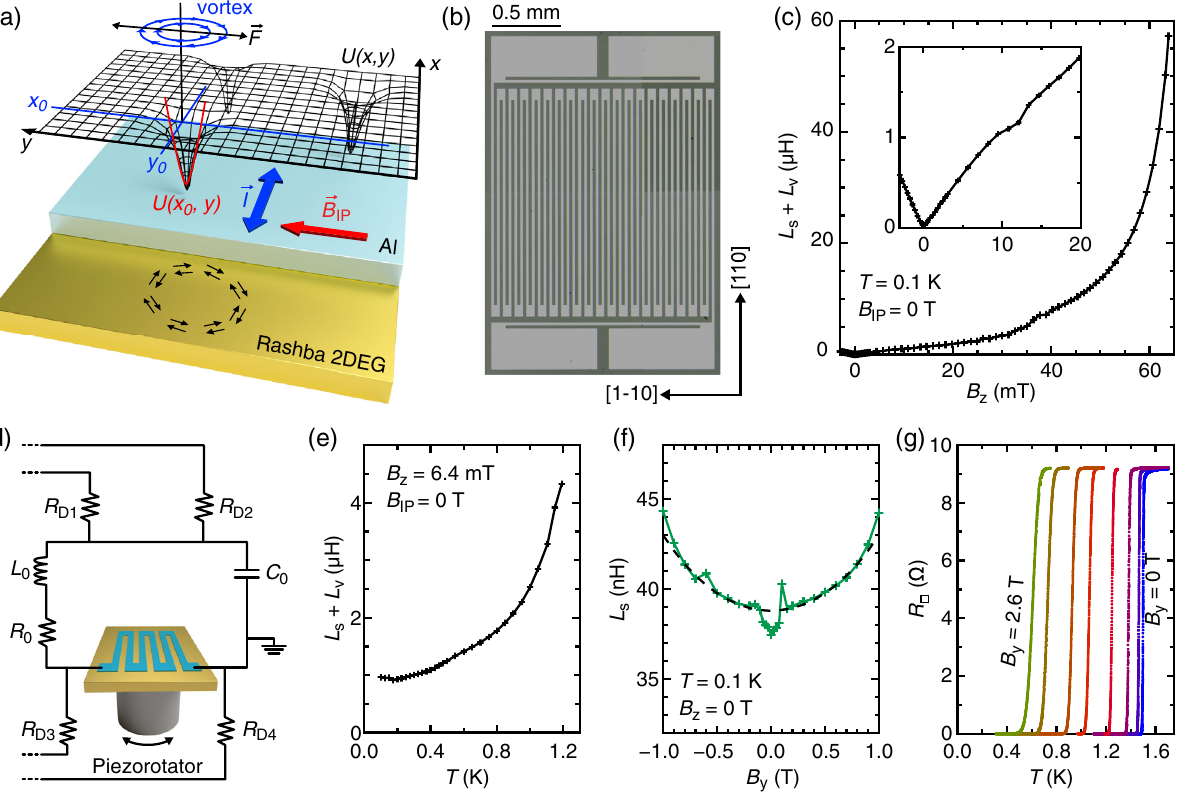
FIG. 1. Vortex inductance as a probe of the pinning potential. (a) Sketch of the device under study. An epitaxial Al film (light blue) proximitizes from the top a shallow InAs quantum well (yellow). The sample is patterned as a 24 - μ m-wide and 7.3-cm-long meander [see micrograph in (b)]. The current flows mainly along the ˆ x direction, and is subjected to a vortex-generating out-of-plane magnetic ˆ x þ B ˆ y at a variable angle θ with respect to the ˆ x axis, which can be controlled. The grid ≡ B field B and an in-plane field B z x y IP represents the vortex free energy U ð x; y Þ for displacement from the pinning centers. An ac current I k ˆ x exerts Lorentz force F k ˆ y . The ð y − y Þ 2 = 2 (red parabola), with k ¼ ∂ 2 U ð x 0 ; y 0 Þ . restoring potential in harmonic approximation (small oscillations) is U ð x 0 ; y Þ ¼ k 0 y y y (b) Optical micrograph of the sample. Light gray area corresponds to the Al film, while the dark green ones are etched down to the mesa. (c) Vortex ( L ) plus kinetic ( L ) inductance as a function of B . In our samples L ( ≈ 40 nH; see next panel) is negligible compared to L . v s z s v The graph shows that by increasing the vortex density, the inductance increases. At low fields (inset) the increase is linear, see Eq. (1). At ¼ 61 mT. (d) Measurement larger vortex densities, the increase is superlinear owing to pair breaking, which leads to divergence at B c 2 scheme: the sample is embedded in a RLC circuit at low temperature and can be rotated with respect to B by means of a piezorotator. IP ¼ 6 . 4 mT as a function of temperature. (f) Kinetic inductance versus B ¼ B ¼ 0 . (e) Measured inductance for B for B z y x z ¼ B ¼ 0 for (right to left) B ¼ 0 , 0.5, 1, 1.5, 2, 2.25, 2.5, 2.6 (g) Temperature dependence of the sheet resistance measured at B x z y